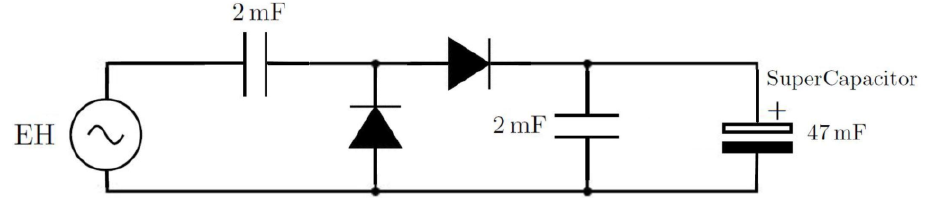
Figure 4. Circuit diagram of the voltage doubler used to rectify the input AC output voltage from the energy harvester.